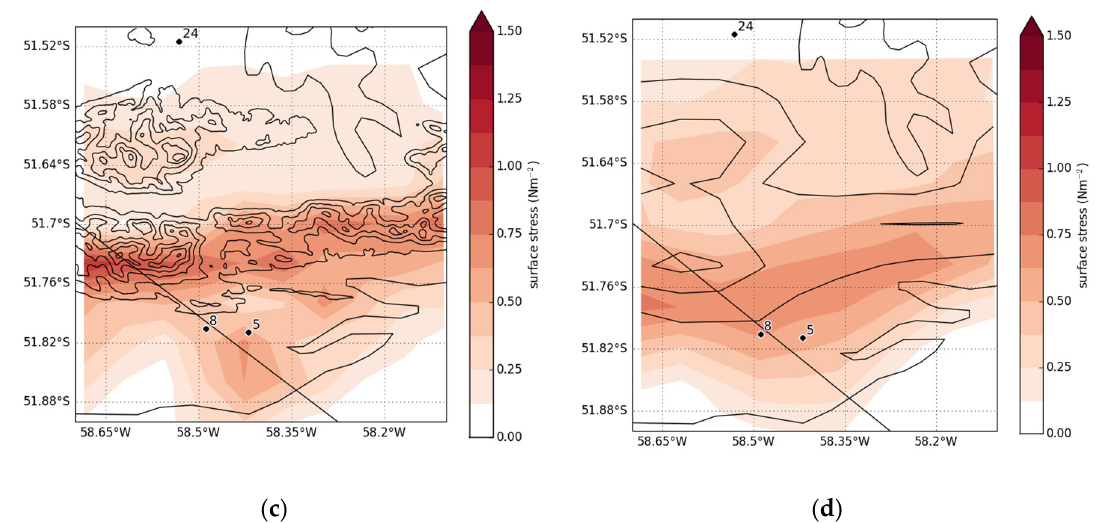
Figure 4. ( a ) Vertical velocities at 500 m altitude from a 100-m resolution simulation; ( b – d ) surface stress from: ( b ) The 100-m resolution simulation; ( c ) coarse-grained onto a 4.4 km grid; and ( d ) simulated at 4.4-km resolution. Simulations are from a one-way nested MetUM simulation of flow over East Falkland at 12 UTC 9 February 2001. Note the colour scale in ( c , d ) is different to that in ( b ).